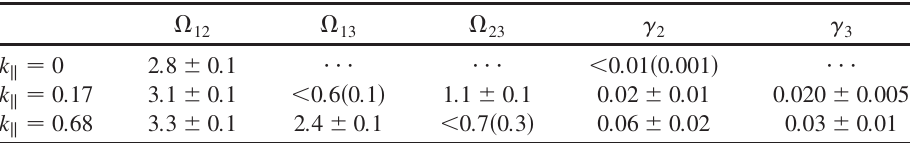
TABLE I. The (cid:1) terms ( j , k ¼ 1 ; 2 ; 3 , and j (cid:1) k ) are the coupling frequencies between the jk j th and k th oscillators, and the (cid:2) terms are the damping frequencies associated with the j th j oscillator, for the system described by Eq. (1). All quantities are given in units of mrad/nm. In the entries for which a minimum estimate is given, the value in parentheses represents the value yielding the spectra in Fig.